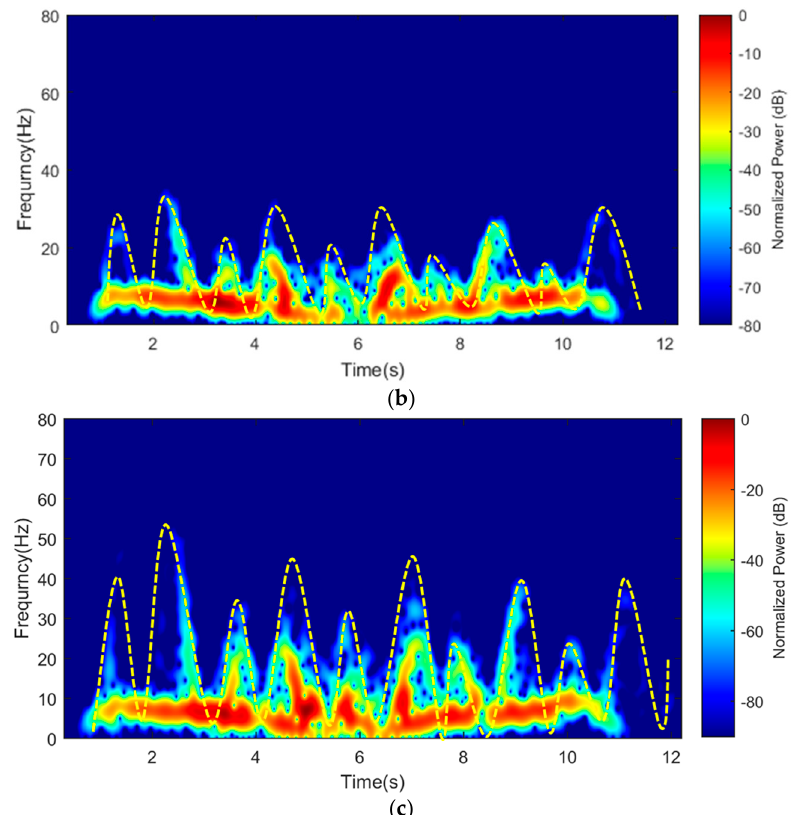
Figure 18. Spectrogram for one pendulum that starts moving in backward motion when the release angles, θ 0 at: ( a ) 20 ◦ ; ( b ) 40 ◦ ; and ( c ) 70 ◦ .